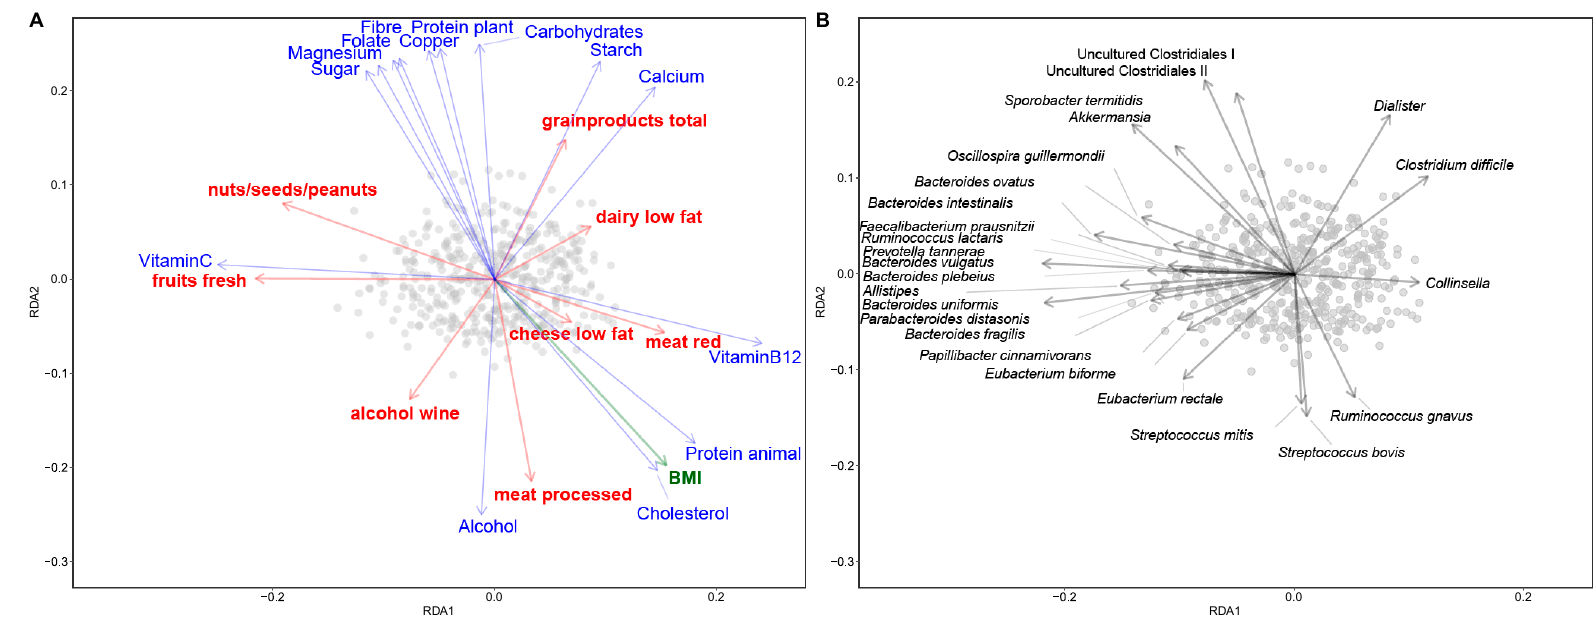
Figure 2. Association of microbiota with food groups, nutrients and BMI. Samples are plotted as grey circles. ( A ) Redundancy analysis (RDA) bi-plot of microbiota with explanatory variables; food groups (red), nutrients (blue) and phenotypical characteristics (green). ( B ) RDA bi-plot of samples with the associated microbial taxa (indicated as genera or species-level groups) The direction of the arrows depicts the abundance of microbial taxa. Length of the arrows is a measure of fit. The variable arrows approximate the correlation between species and explanatory variables. Samples near the coordinate origin (zero point) suggest near zero correlation. The further a sample falls in the direction indicated by the arrow, the higher the correlation.